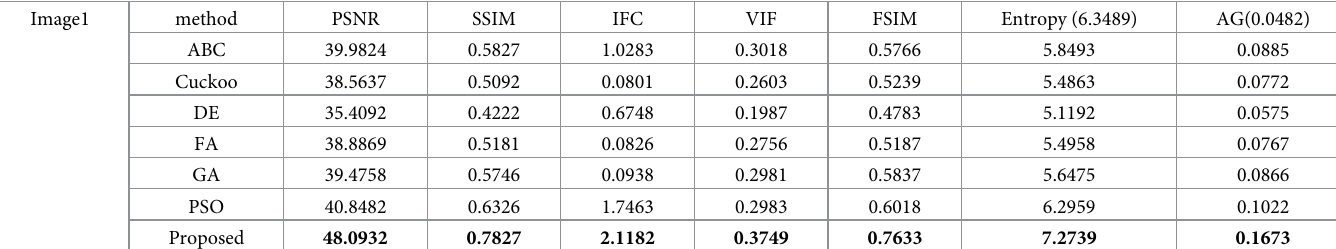
Table 5. The performance evaluation of various image contrast enhancement approaches using test images 1. Image1